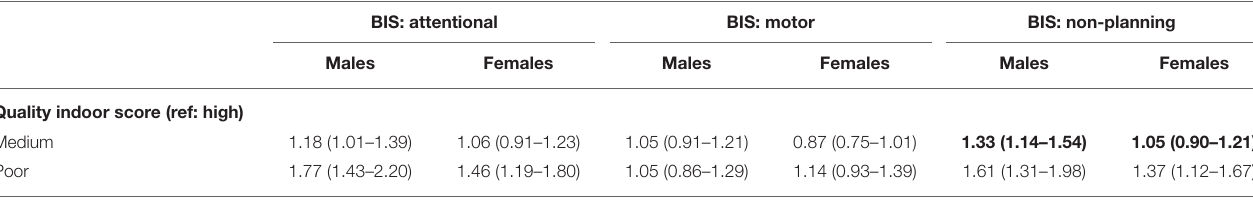
TABLE 3 | Odds ratio* (OR) and their 95% confidence intervals (CI) for the association between the quality indoor score and the three impulsivity components, in males and females, separately. BIS: attentional